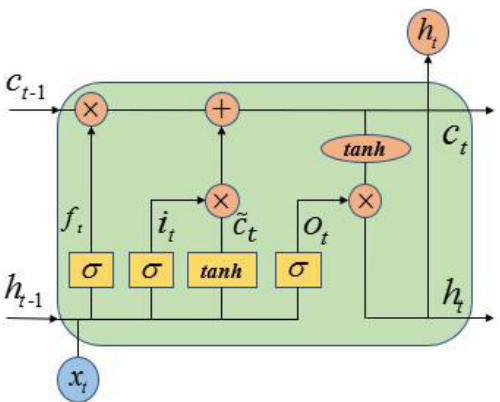
Figure 7. Architecture of long short-term memory (LSTM) memory cell.